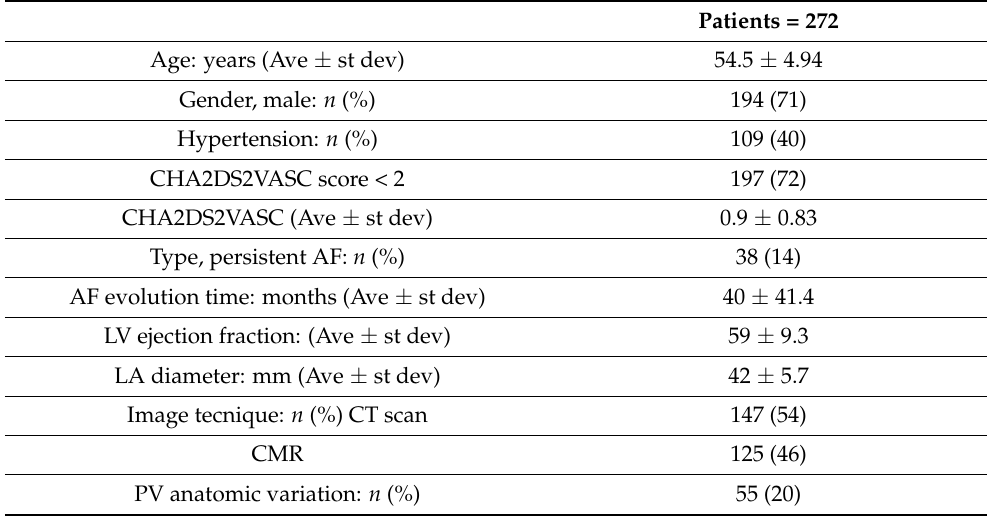
Table 1. Population